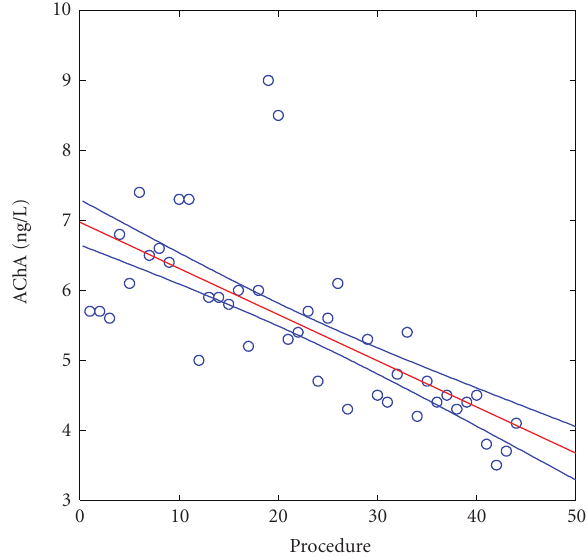
Figure 3: AChRA levels in patient no. 3. X axis: Procedure = numeral order of procedures from the start of therapy; Y axis = AChRA levels in ng/L. Normal value in our laboratory = 0.00–